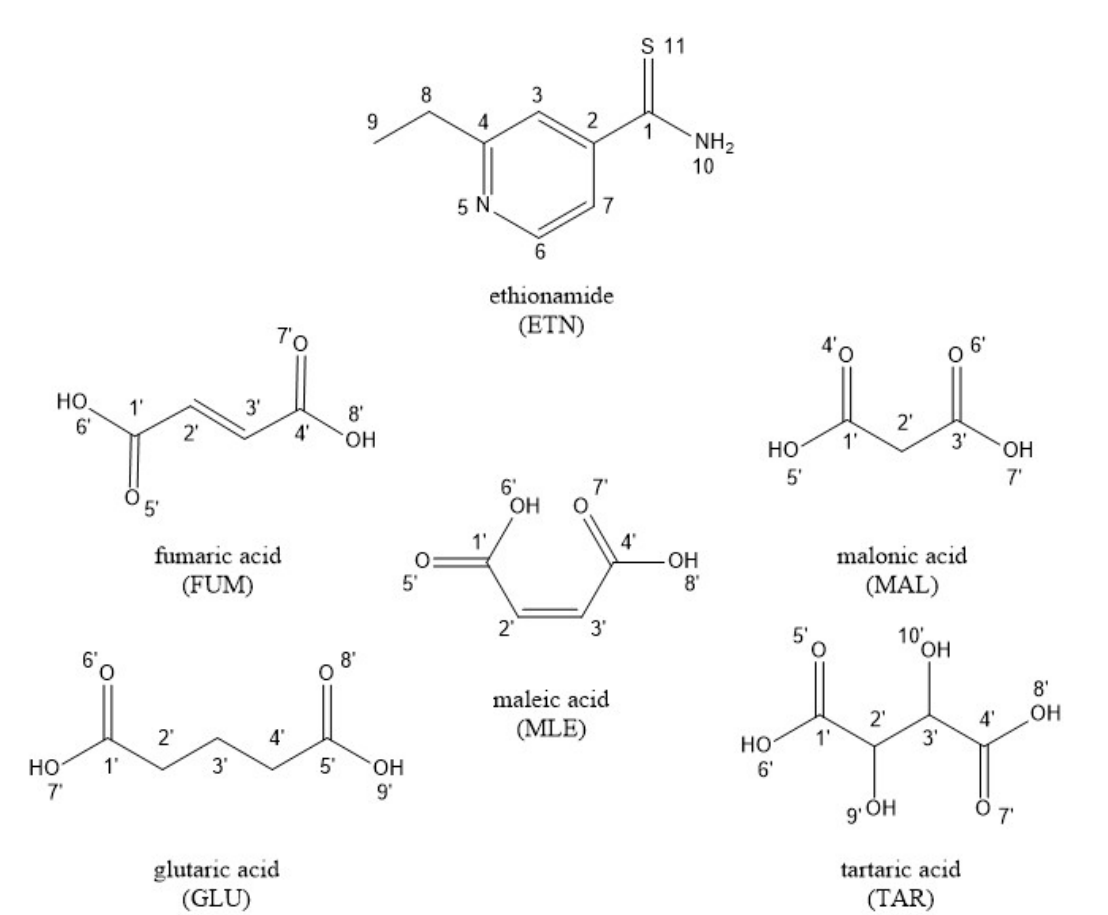
Scheme 1. Representation of the employed molecules, with atom numbering.